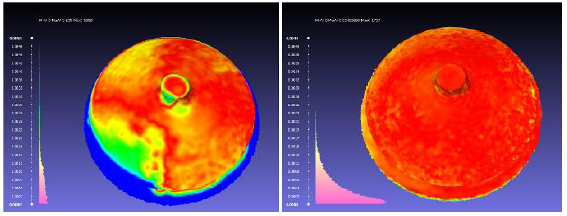
Figure 10. Hausdorff distance calculation between the 3D Creator model and Canon- Photoscan model (on the left), the Xperia- Photoscan model and Canon- Photoscan models (on the right).